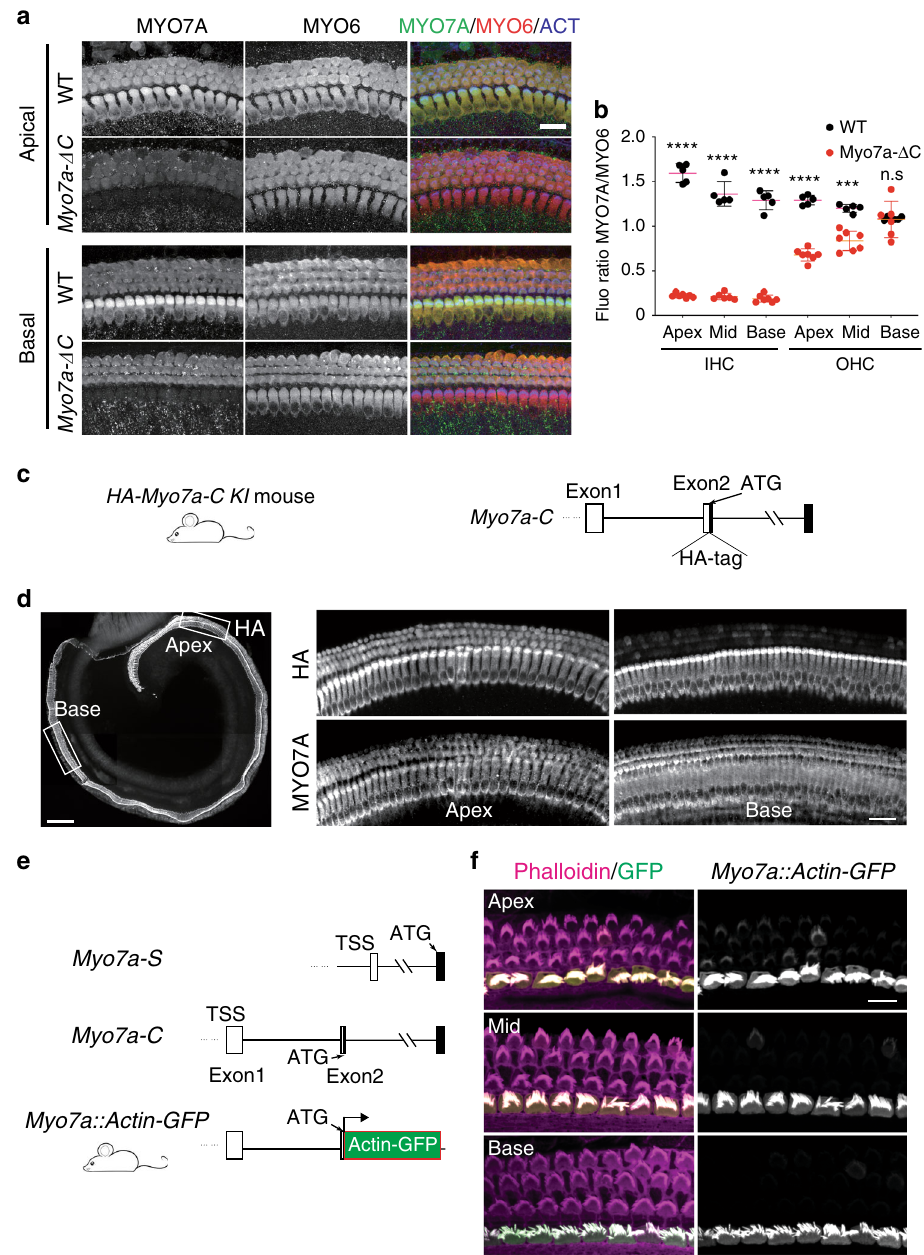
Fig. 3 MYO7A-C is expressed primarily in IHCs and in a tonotopic gradient in OHCs, with decreasing expression toward the cochlear base. a MYO7A and MYO6 immunoreactivity in apical and basal turns of organ of Corti of P5 Myo7a- Δ C and WT mice (scale bar: 20 μ m). b MYO7A immunoreactivity was quanti fi ed in apical, middle, and basal turns by normalizing to MYO6 immunoreactivity. Compared with WT, MYO7A levels in Myo7a- Δ C mice were reduced by ~85% ( p < 1e − 4) in all IHCs, and by ~30% and 52% ( p < 1e − 3 and <1e − 4) in middle and apical-turn OHCs. Each data point in b corresponds to a mean MYO7A/MYO6 immuno fl uorescence ratio (mean of 12 IHCs and 36 OHCs per organ and position). Error bars indicate SD. N (animals) = 5 in WT and 7 in Myo7a- Δ C . p values in b were derived from two-tailed, unpaired t -tests. c Design of the HA-Myo7a-C KI mouse. HA-tag was knocked-in after the ATG of Myo7a-C by CRISPR-mediated gene editing. d Organ of Corti of an HA-Myo7a-C KI mouse, stained with a HA-speci fi c antibody. The white boxes indicate approximate positions of the apical and basal cochlear regions shown on the right. HA immunoreactivity, representing the expression of MYO7A- C, is strong in all IHCs. In OHCs, HA immunoreactivity is readily detected at the cochlear apex, but decreases toward the base (scale bars: 200 μ m in whole organ of Corti image, 20 μ m in magni fi ed panels). e The genomic position from which the Myo7a promoter used in the Myo7a::Actin-GFP transgenic mouse is derived. f Actin-GFP signal and phalloidin reactivity in the organ of Corti of Myo7a ::Actin-GFP transgenic mice at P6. The Actin-GFP signal was predominantly observed in the IHCs. Actin-GFP signal was detected at low levels in the apical OHCs, and decreased tonotopically toward the basal end of the cochlea (scale bar: 10 μ m). Source data are provided in the Source Data fi